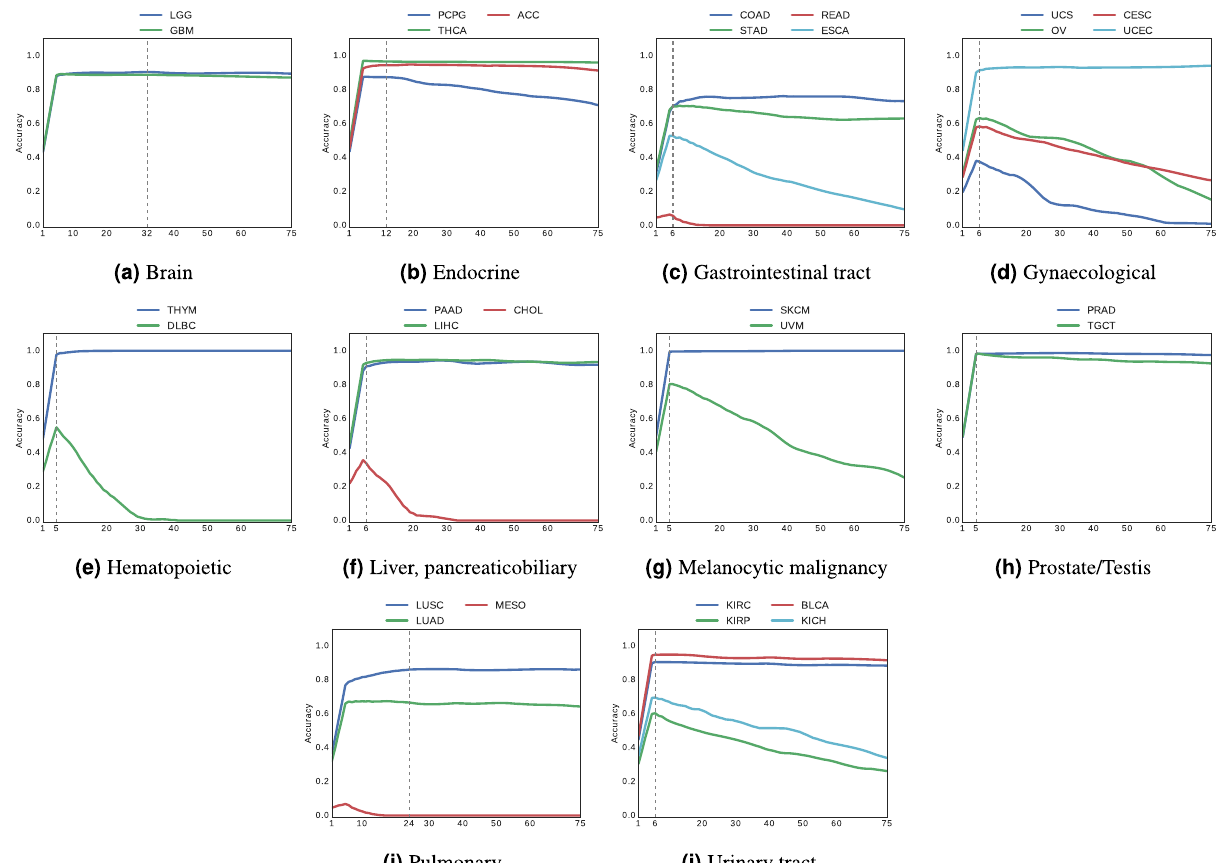
Fig. 4 Accuracy of vertical search for diagnostic slides. Vertical search in permanent diagnostic slides from different anatomic sites ( a – j ) with at least two cancer